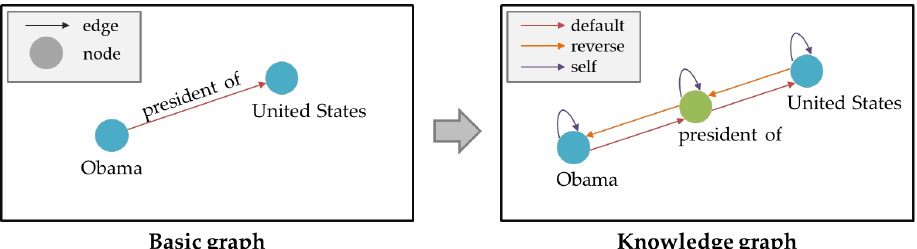
Figure 5. Example of converting a basic graph into a knowledge